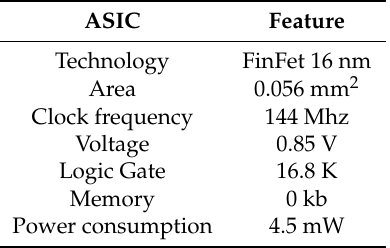
Table 9. ASIC design